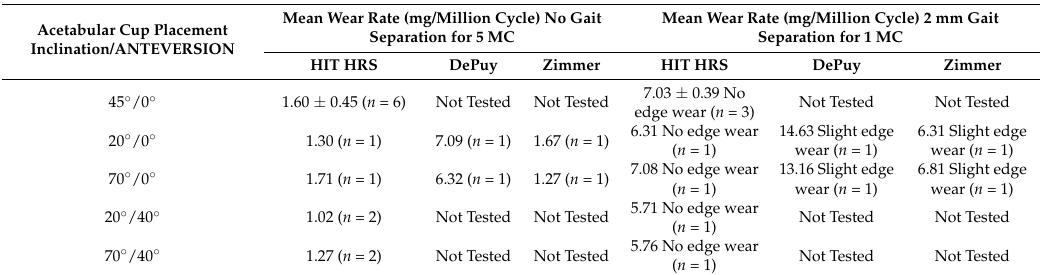
Table 2. Wear generation of the reverse hip system versus two conventional systems under normal and gait separation